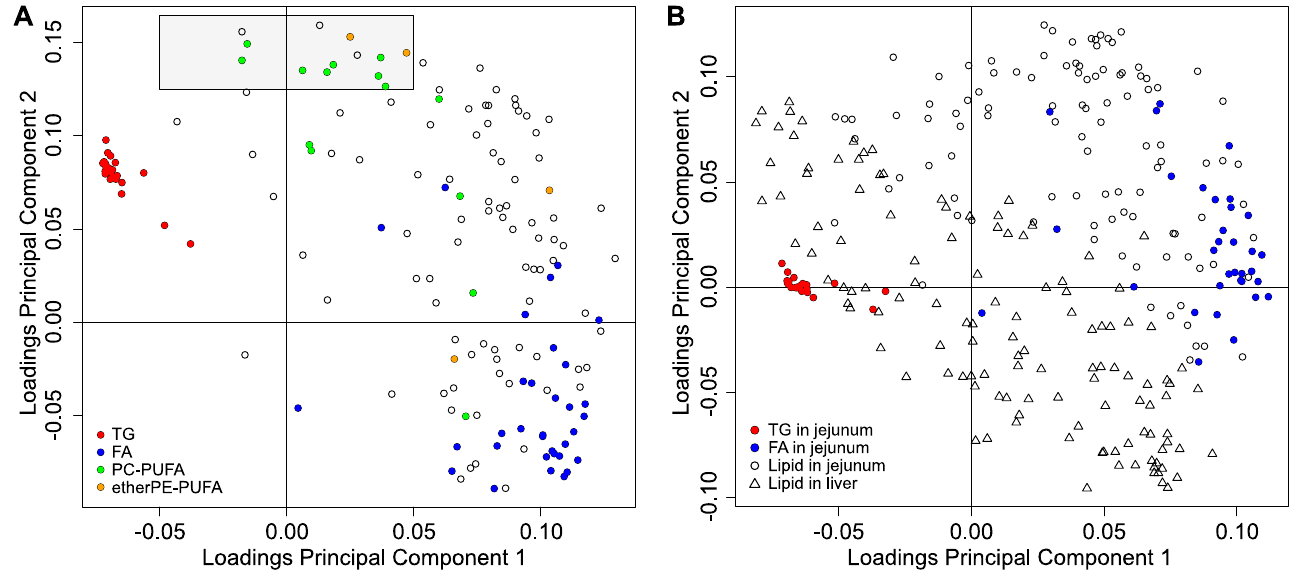
Figure 2. Loadings of the principal component analysis of the jejunal and hepatic lipidomes. ( A ) Loadings plot of the first and second principal components of the lipidome in the jejunum. Triacylglycerols (TGs) in red; free fatty acids (FAs) in blue; polyunsaturated − fatty − acid − containing phosphatidylcholines (PC − PUFA) in green; and polyunsaturated − fatty − acid − containing etherglycerophospholipids of ethanolamine (etherPEs − PUFA) in orange. ( B ) Loadings plot of the first and second principal components of the principal component analysis of joining the lipidomes of the jejunum (circles) and the liver (triangles). Jejunal TGs in red and jejunal FAs in blue. The scores of both models can be found in Figure S1.